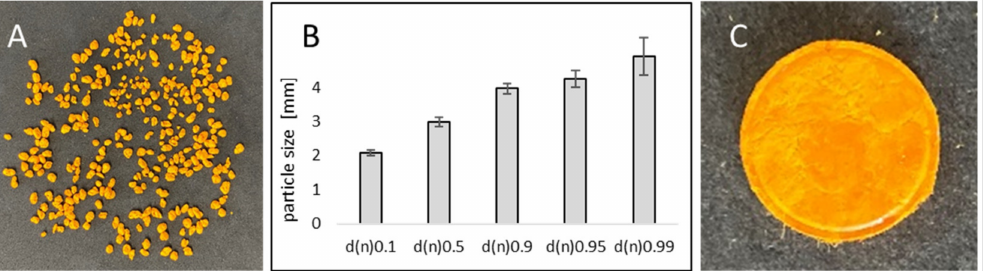
Figure 2. ( A ) Macroscopic image of smartFilm granules loaded with curcumin. ( B ) Numeric size distribution of the curcumin-loaded smartFilm granules. ( C ) Macroscopic image of a smartFilm tablet produced from the smartFilm granules loaded with